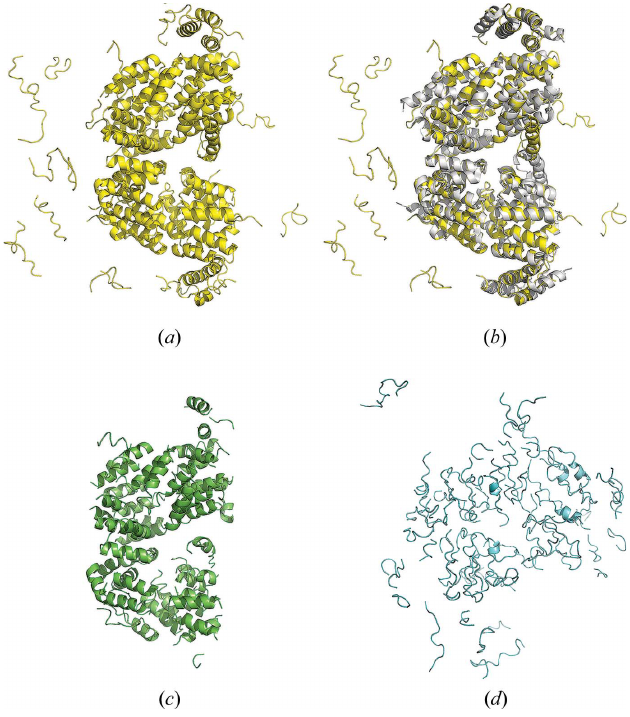
Figure 3 Method comparison, case study 1. ( a ) Model from IPCAS ; ( b ) model from IPCAS superimposed with the crystal structure (PDB entry 4rg6); ( c ) model from Phenix.AutoBuild ; ( d ) model from Buccaneer . Figure 4